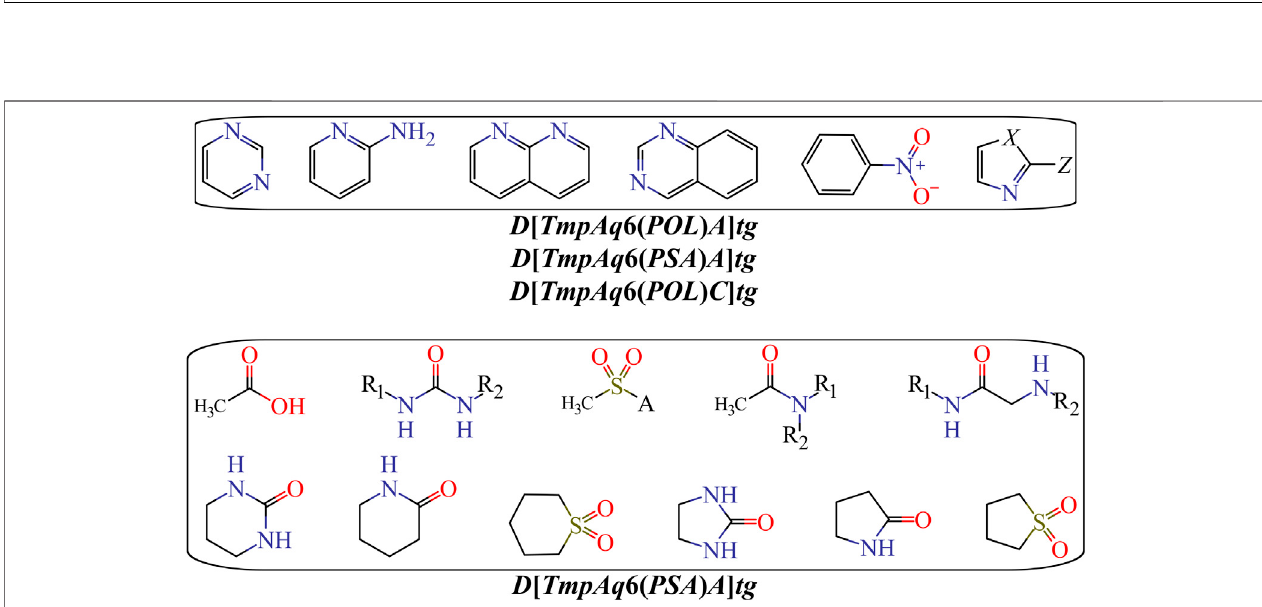
FIGURE5| FragmentswhosepresencepositivelyincreasethePOL{ D [ LmpAq6 ( POL ) A ] tg }orthePSA{ D [ LmpAq6 ( PSA ) A ] tg }.Here,A (cid:1)− NH 2 , − OH,orR(alkyl group); X (cid:1) − NH − , O, or S; Z (cid:1) Cl, Br, I, or − SH; substituents R 1 and/or R 2 can be H, alkyl or aryl groups.